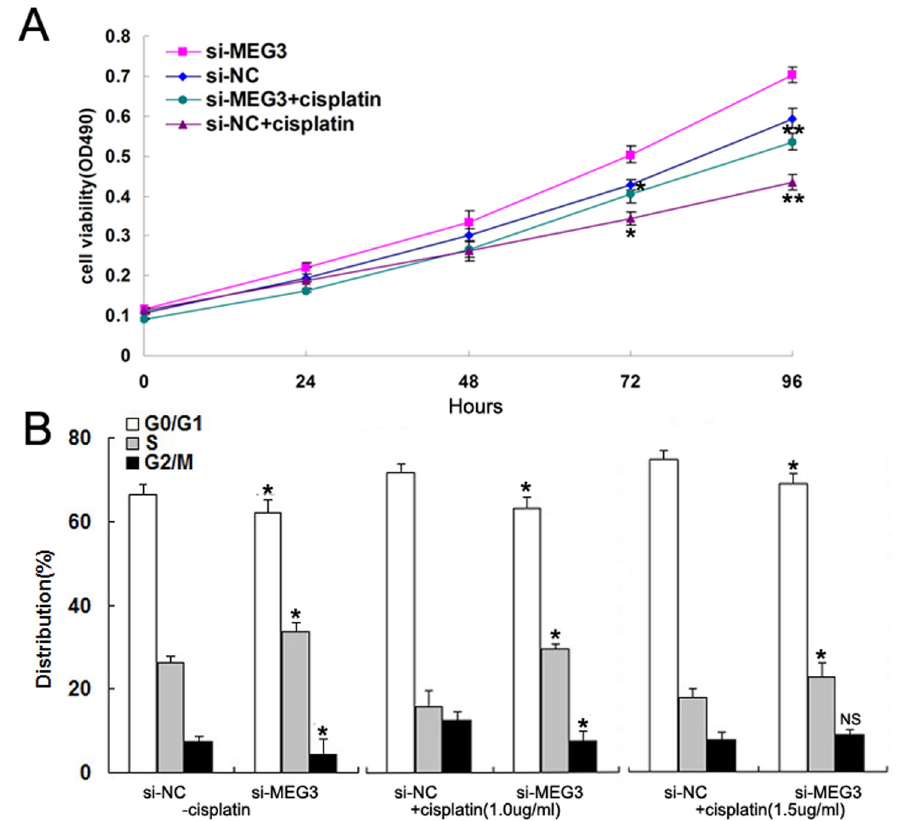
Fig 5. Knockdown of MEG3 promotes A549 cell proliferation in vitro . (Fig 5A) MTT assay of the proliferation of si-NC- and si- MEG3 -transfected A549 cells. (Fig 5B) Flow cytometry analysis of cell cycle distribution in combination with increasing concentrations of cisplatin (0.0, 1.0, and 1.5 μ g/ml). * P < 0.05, ** P < 0.01.